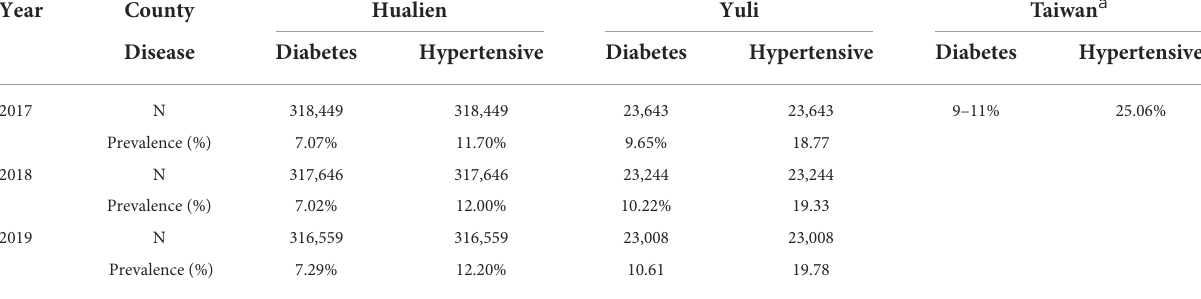
TABLE 3 Descriptive statistics of the prevalence rates of diabetes and hypertension in Hualian and Yuli